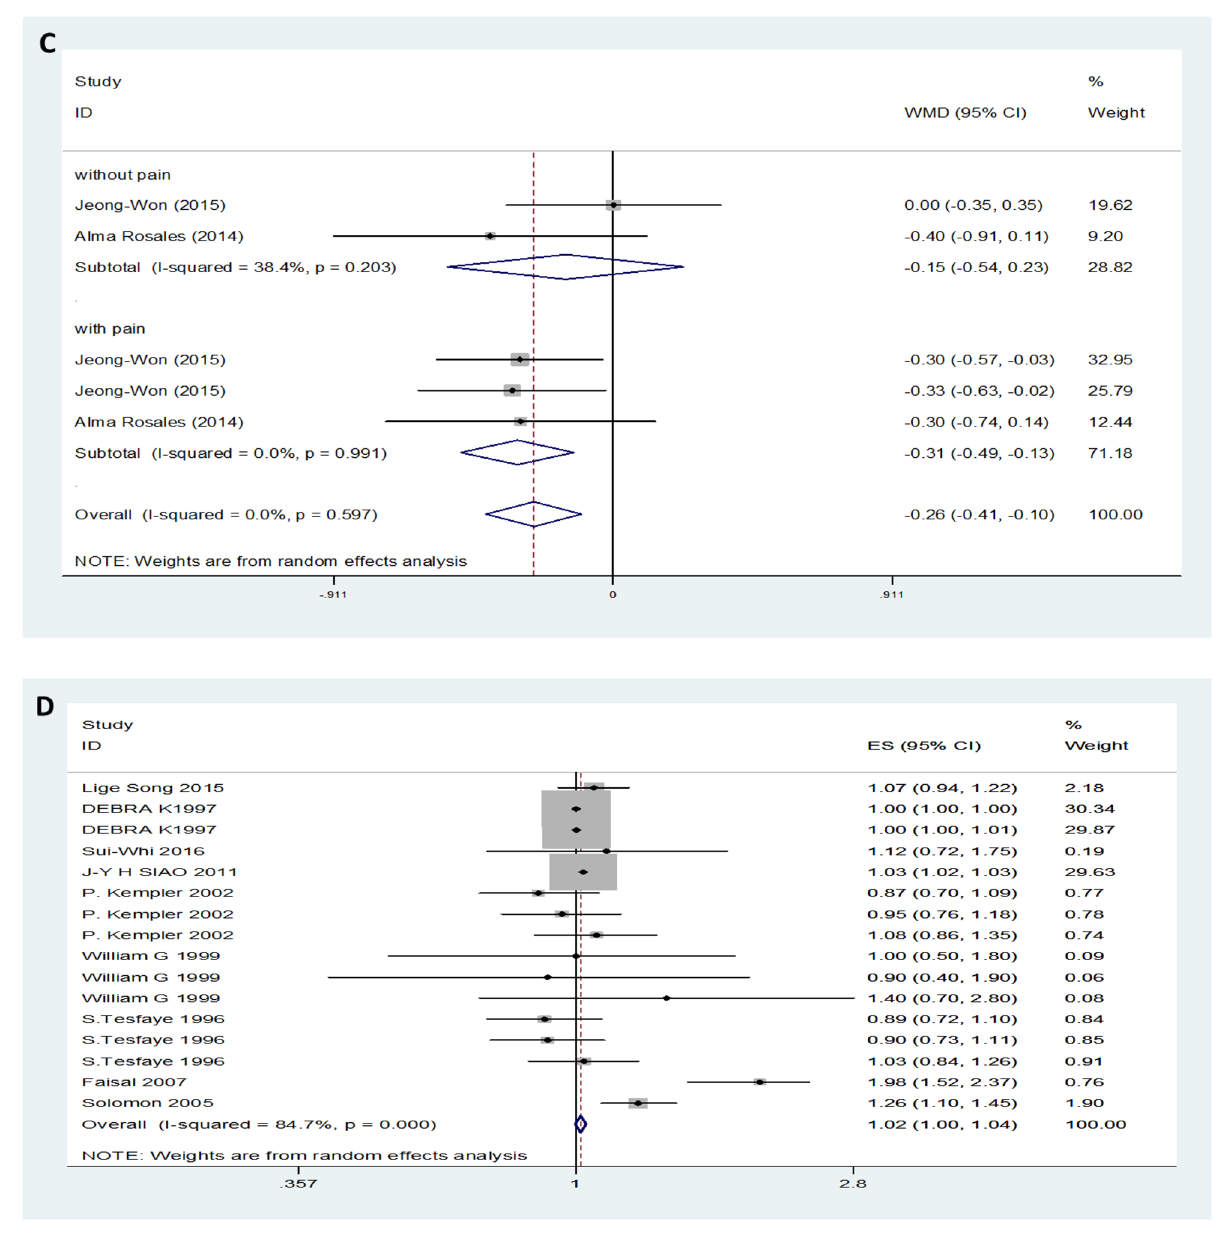
Serum HDL levels between of DN and non‑DN patients/healthy controls. Data on HDL